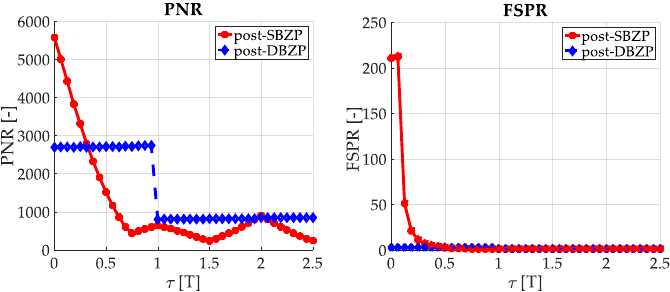
Figure 6. Result of the utilization of the single-step PCS post-correlation schema with SC, detail of Figure 5 .